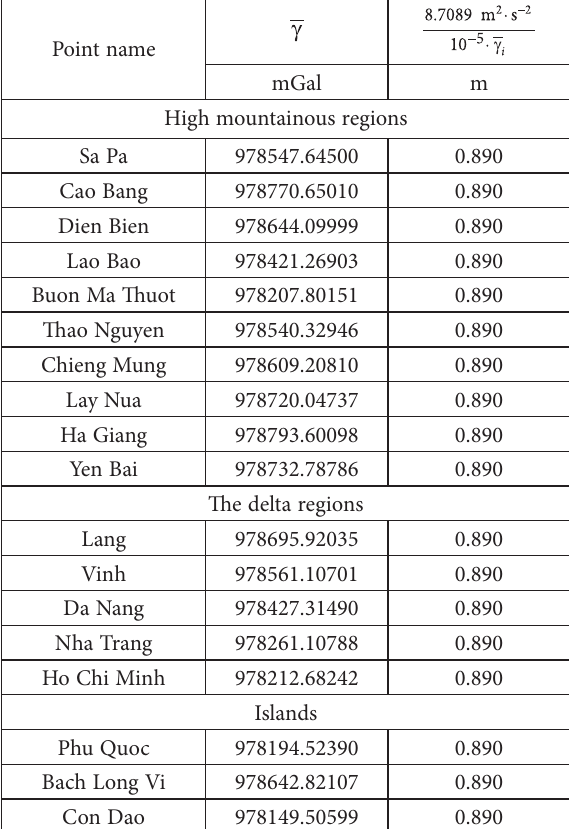
Table 2. Estimation of height of local quasigeoid in relation to global quasigeoid in whole territory of